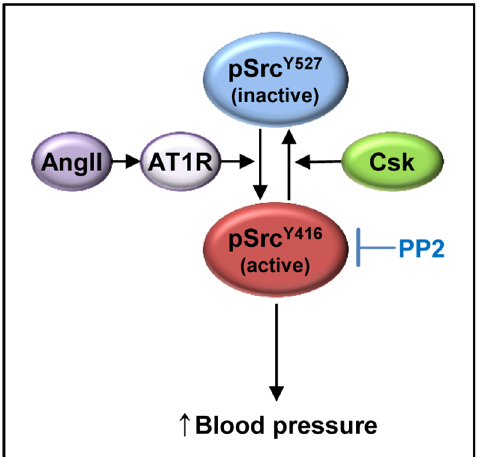
Fig 6. The working model of blood pressure regulation by Csk and Angiotensin II through Src. Angiotensin II (Ang II) increases blood pressure through angiotensin type 1 receptor (AT1R) dependent on the Csk/Src signal. Csk, a negative regulator of Src increases phosphorylation of Src Y527 (inactive) and decreases that of Src Y416